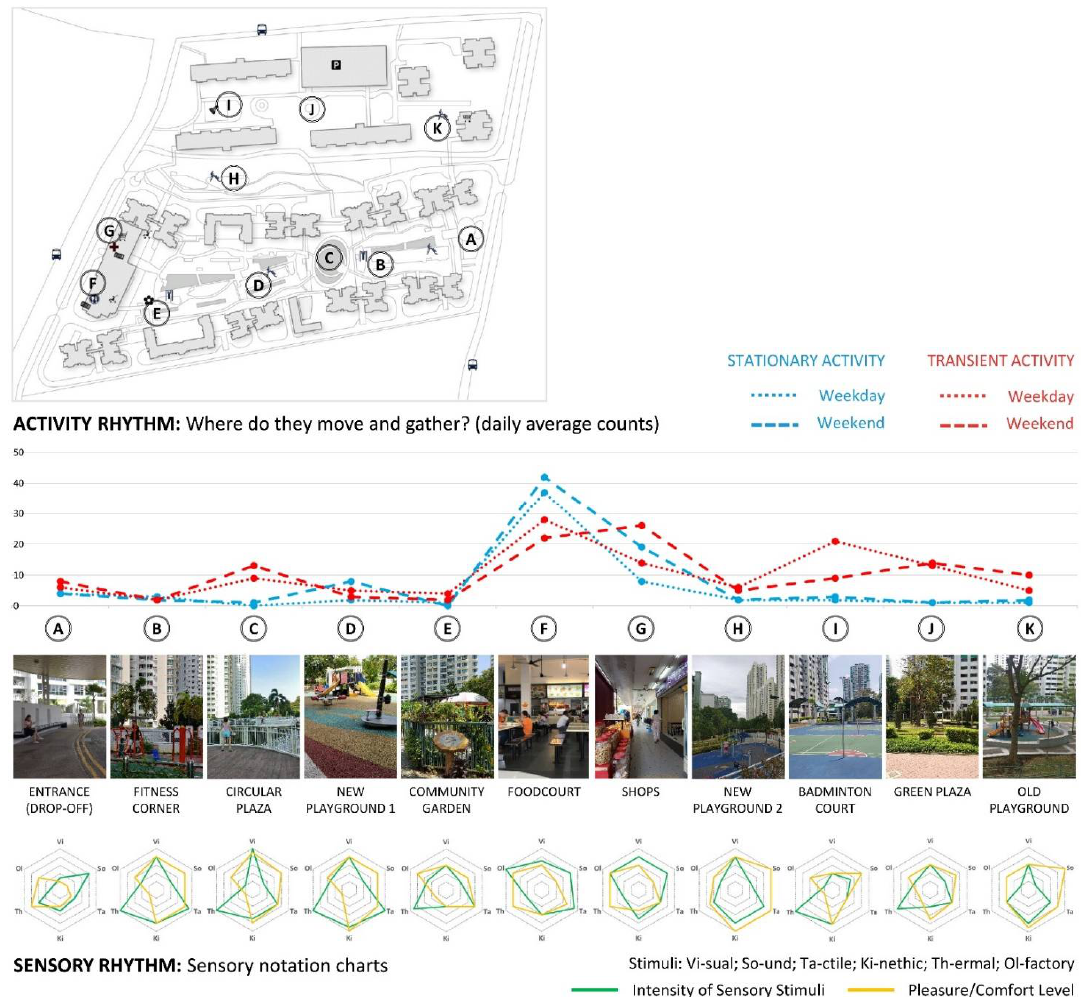
Figure 7. Summary of rhythm analysis in Clementi neighbourhood (source: by